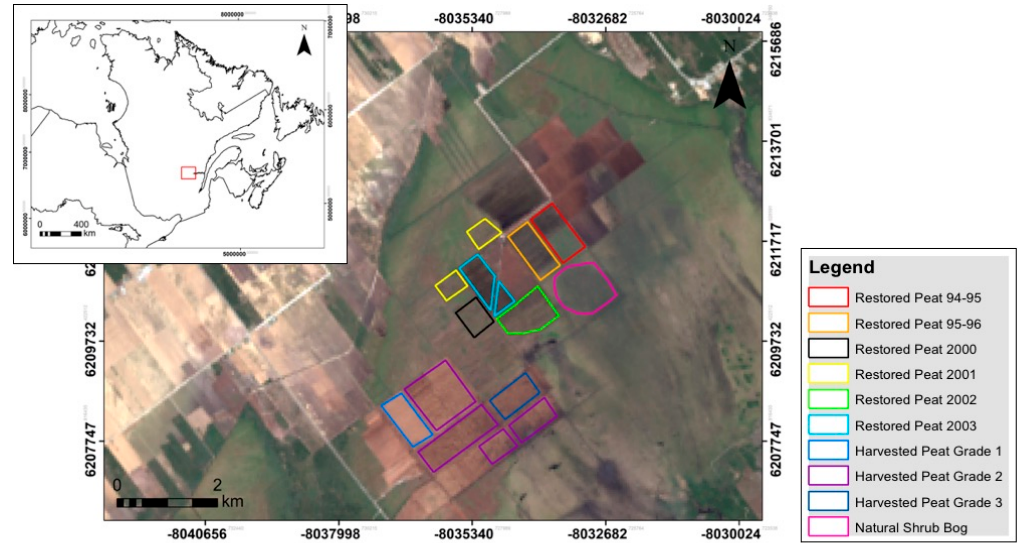
Figure 1. Location map of the Sainte-Marguerite-Marie peatland in Quebec, Canada. The map on the top left shows the location of the Sainte-Marguerite-Marie peatland (red box) in relation to the rest of Quebec, Canada. The lower map shows a close-up view of the Sainte-Marguerite peatland with examples of restored peat from different years, different grades of harvested peat, and natural shrub bog, which were all included in the analysis for this research. The background is a Landsat-8 image.